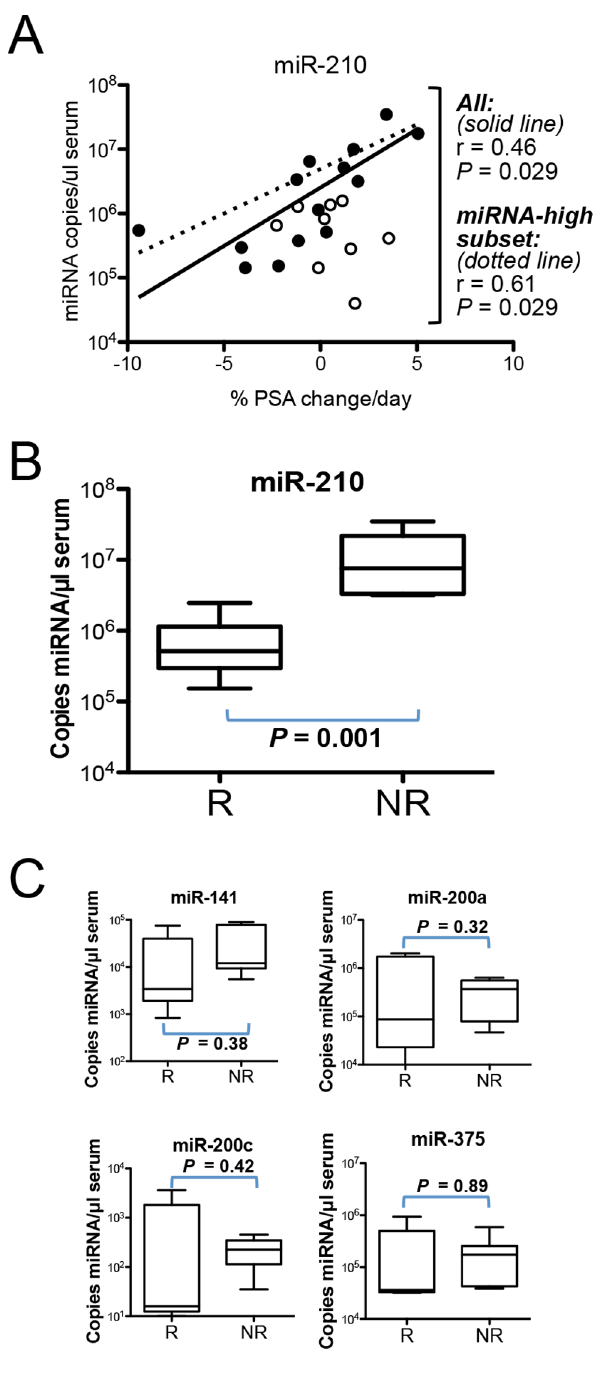
Figure 3. Relationship between serum miR-210 levels and PSA response in patients with metastatic castration resistant prostate cancer. Upper: miR-210 copies/ m l serum versus %PSA change/day. %PSA change/day represents a measure of response to treatment and was calculated using available clinical PSA values measured most recently prior to, and at the time of serum miR- 210 draw. Mean time elapsed between the two blood draws was 30 days. Closed circles represent the subset of patients defined as "miRNA-high" based on higher abundance of mCRPC-associated serum miRNAs compared to all control individuals (as described in Results and Discussion). Open circles represent the patients with mCRPC who did not meet the definition for ‘‘miRNA-high’’. Solid line represents trend line of the miRNA-high patient subset, dotted line represents trend